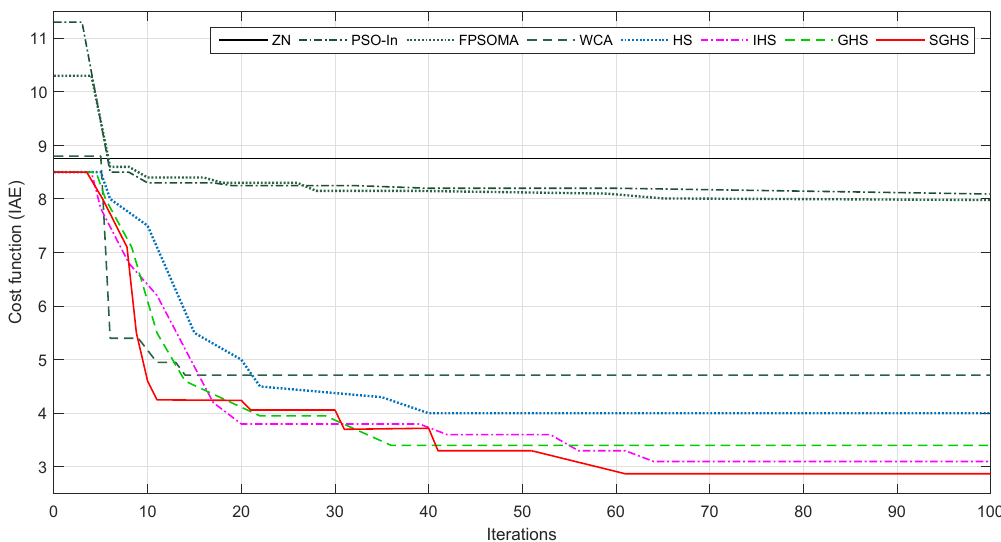
Figure 12. Convergence histories of the HS, IHS, GHS and SGHS algorithms for Problem (18).